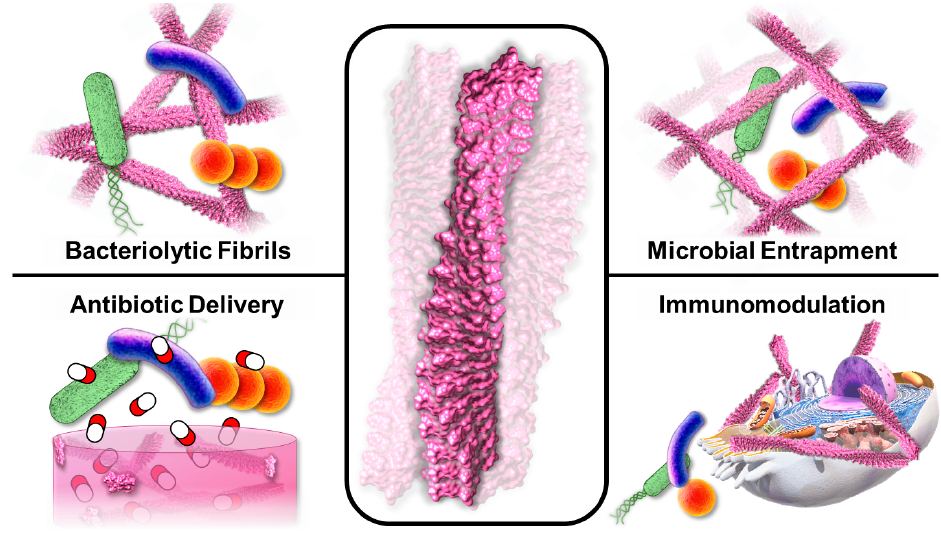
Figure 1. Peptide assemblies adopt diverse supramolecular morphologies to elicit antimicrobial responses via contact-dependent bacteriolysis, delivery of small molecule antibiotics from macroscopic materials, physical entrapment of pathogens in nanonets, or binding to hosts cells to stimulate innate and adaptive immune responses.